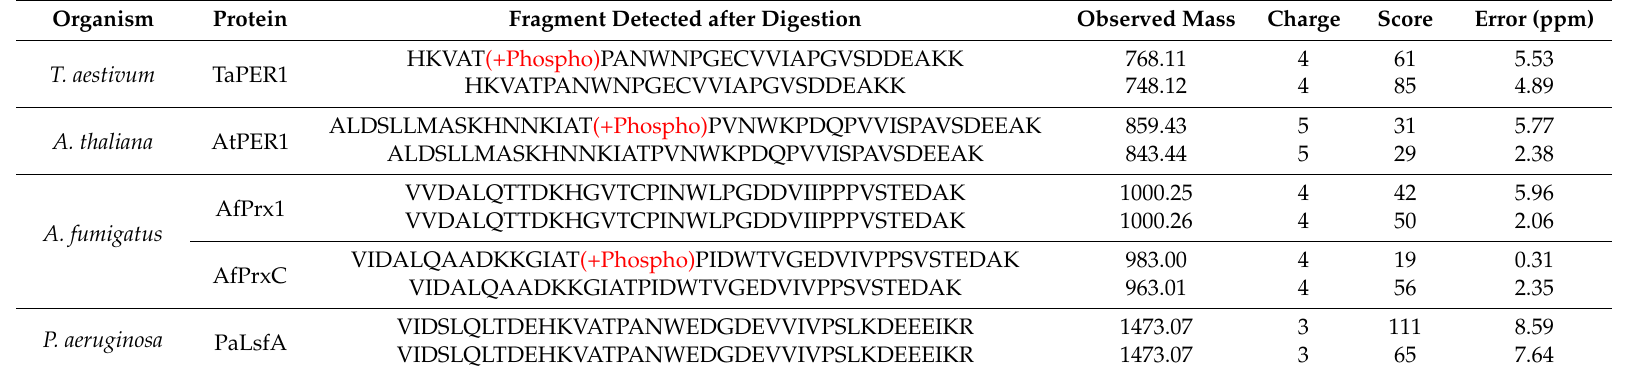
Table 2. MS/MS analysis of 1-Cys Prdx purified proteins after human Erk2 treatment and digestion. Only the peptides containing the Thr homologous to Thr177 of human Prdx6 are shown. The presence of phosphorylation is indicated in red